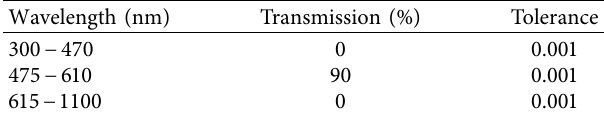
Table 5: Deposition parameters for Nb